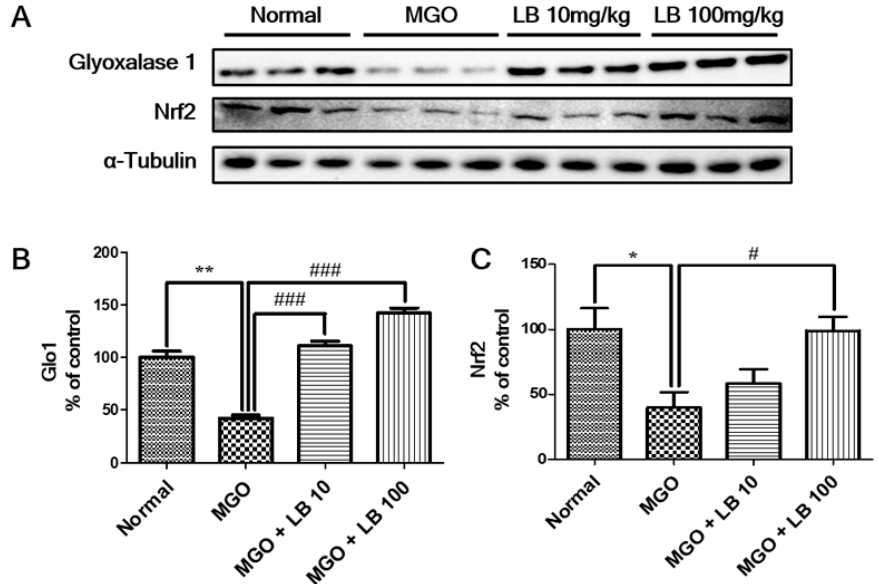
Figure 6. The e ff ect of LB on the expression of Glo1 and Nrf2 proteins in the kidneys of the MGO-treated mice. ( A ) Expression of Glo1 and Nrf2 as measured by western blot analysis. ( B , C ) The relative band intensities of Glo1 and Nrf2. The bar values represent the mean ± SEM (# p < 0.05 vs. MGO treatment, and * p < 0.05, ** p < 0.01 vs. the control, n =